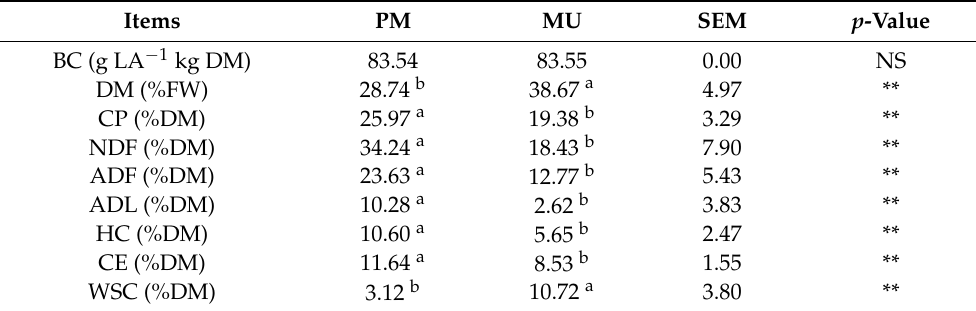
Table 1. Characteristics of woody forage raw